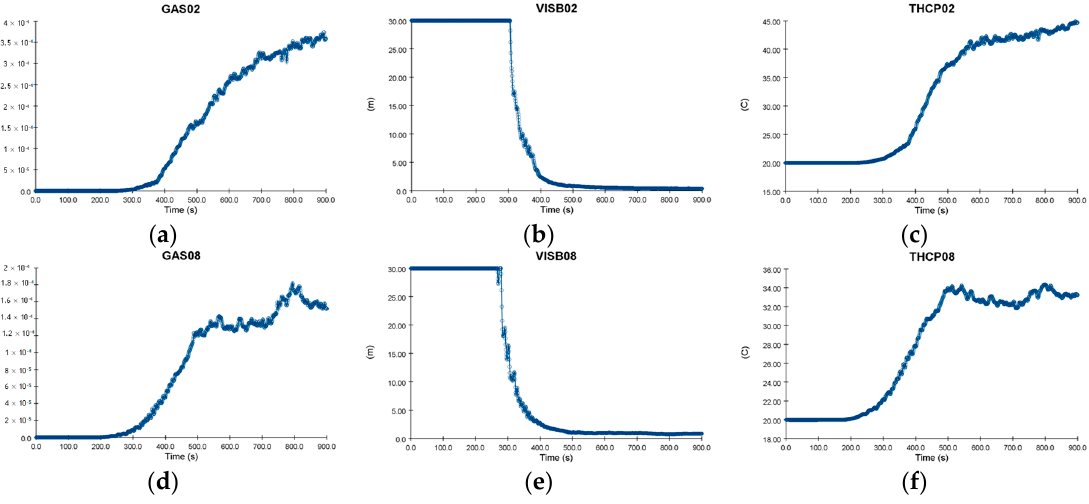
Figure 14. Change curves of fire characteristics under working condition A: ( a – c ): left transverse passageway; ( d – f ): right transverse passageway.